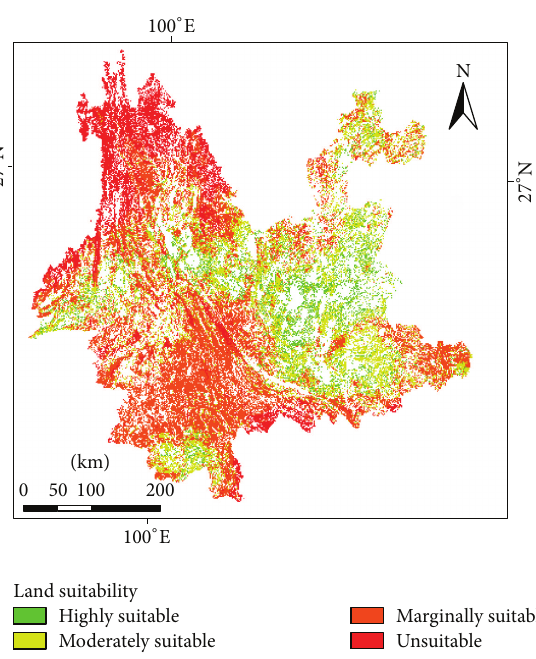
Figure 8: Classification map of land use suitability in low-slope hilly regions in